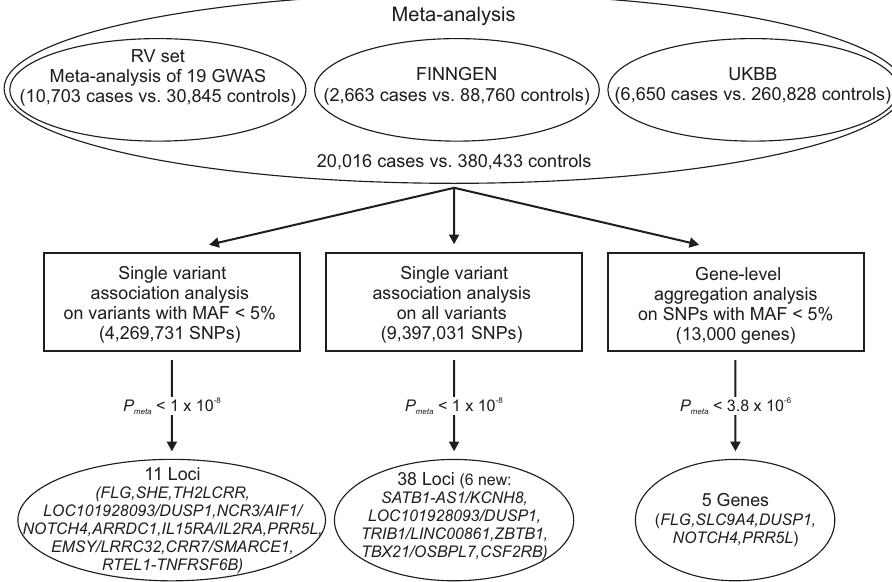
Fig. 1 Study design of the meta-analysis of genome-wide association studies (meta-GWAS) on rare variants in eczema. Work fl ow of the meta-GWAS on rare variants in eczema is shown. Analyzing only rare/low-frequency variants, 11 loci were detected. In the complete data set, 38 loci were detected of which 6 were not reported to be associated with eczema or allergic disease previously. The signi fi cance threshold for the gene-level association analysis corresponds to 13,000 genes under study (carrying at least two variants with MAF < 0.05 and a CADD score ≥ 12.37). SNP single nucleotide polymorphism, MAF minor allele frequency.